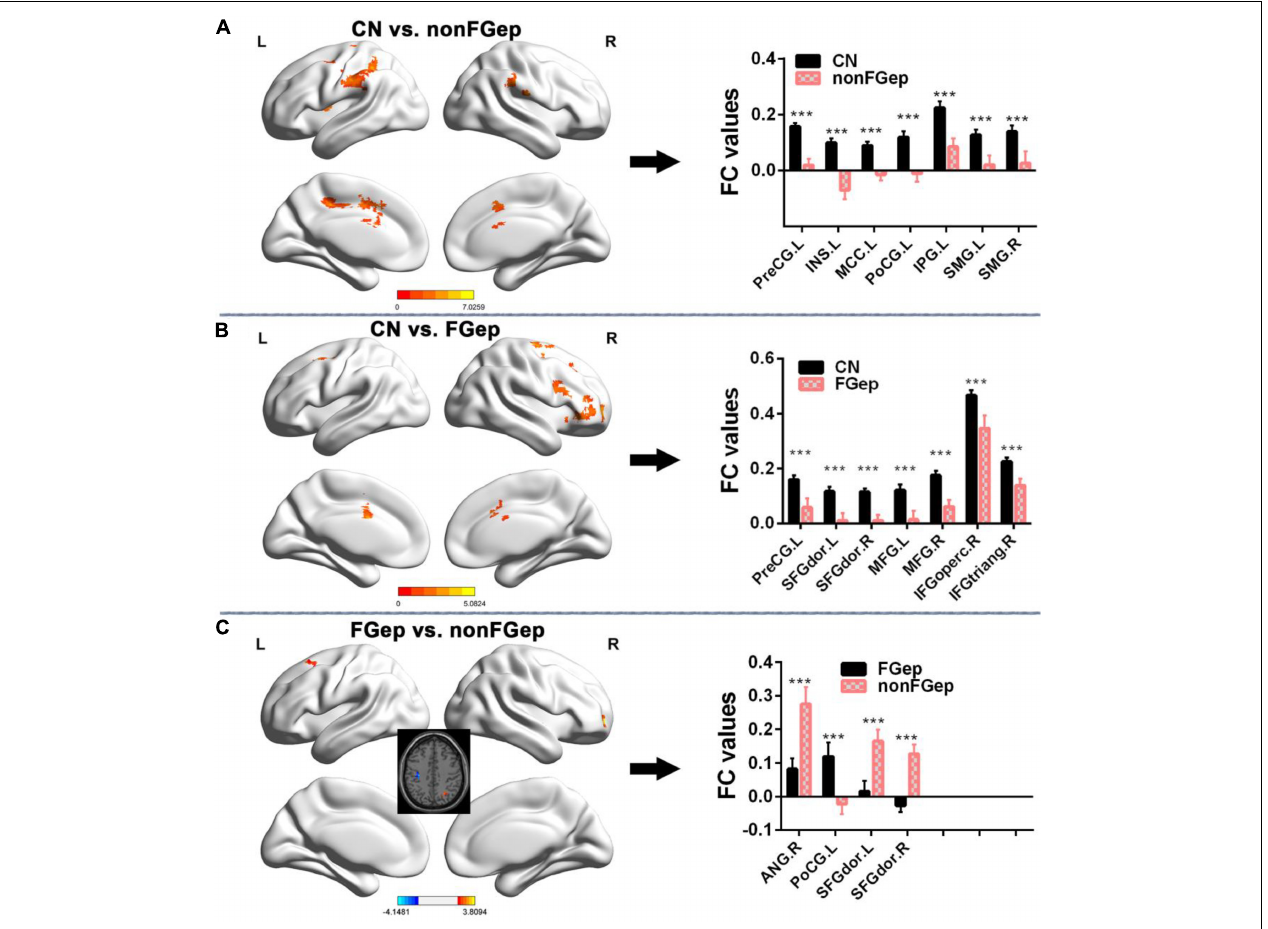
FIGURE 2 | Comparison of FC within the executive control network between CN, non-FGep, and FGep subjects. (A) Altered regions of FC within the executive control network in non-FGep patients compared with CN. The bar chart on the right shows the quantitative comparison of FC in these altered regions. *** p < 0.001. (B) Altered regions of FC within the executive control network in FGep patients compared with CN. The bar chart on the right shows the quantitative comparison of FC in these altered regions. *** p < 0.001. (C) Different regions of FC within the executive control network between FGep and non-FGep patients. The bar chart on the right shows the quantitative comparison of FC in these different regions. *** p < 0.001. CN, healthy controls; non-FGep, frontal glioma without epilepsy; FGep, frontal glioma with epilepsy; L, left hemisphere; R, right hemisphere; PreCG, Precentral gyrus; INS, Insula; MCC, Middle Cingulate and paracingulate gyri; PoCG, Postcentral gyrus; IPG, Inferior parietal gyrus; SMG, Supramarginal gyrus; SFGdor, Superior frontal gyrus, dorsolateral; MFG, Middle frontal gyrus; IFGoperc, Inferior frontal gyrus, opercular part; IFGtriang, Inferior frontal gyrus, triangular part; ANG, Angular gyrus; FC, functional